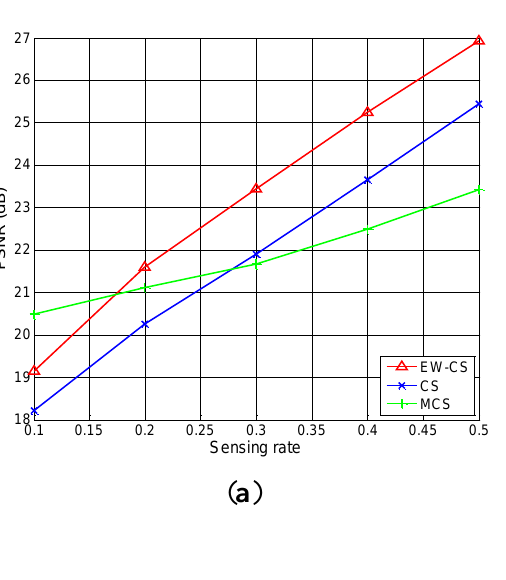
Figure 8. The PSNR performances with different sensing rates. ( a ) “Aerial”, ( b ) “Boat”, ( c ) “Lena”, ( d )